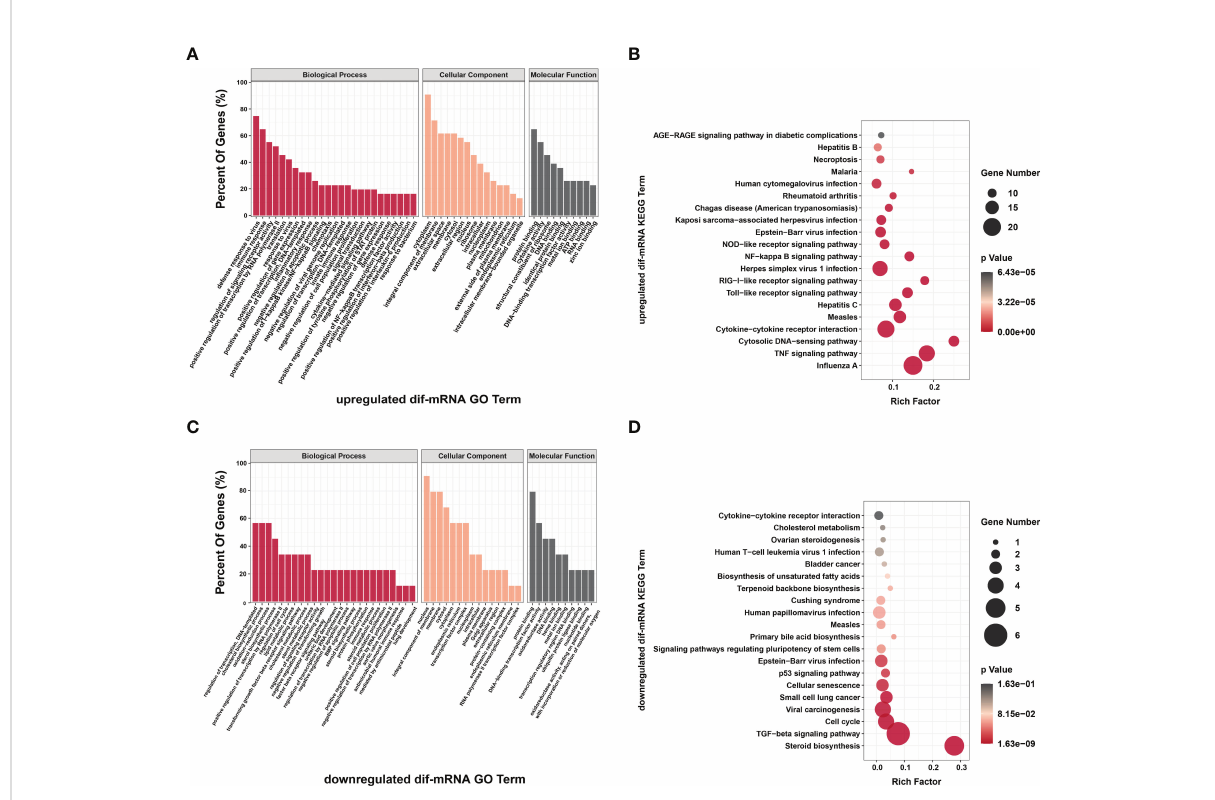
FIGURE 9 Go annotation and KEGG enrichment of upregulated and downregulated dif-mRNAs displayed in the extracted six modules. Top 50 GO terms and top 20 KEGG pathways were shown. (A, C) The height of bar chart represented the ratio of enriched dif-mRNAs under speci fi c GO terms. (B, D) Rich factor of the KEGG scatter diagrams indicated the ratio of dif-mRNAs enriched to the speci fi c pathway. The size of and the color of the solid circulars represented the number of enriched dif-mRNAs and signi fi cance of the enrichment,